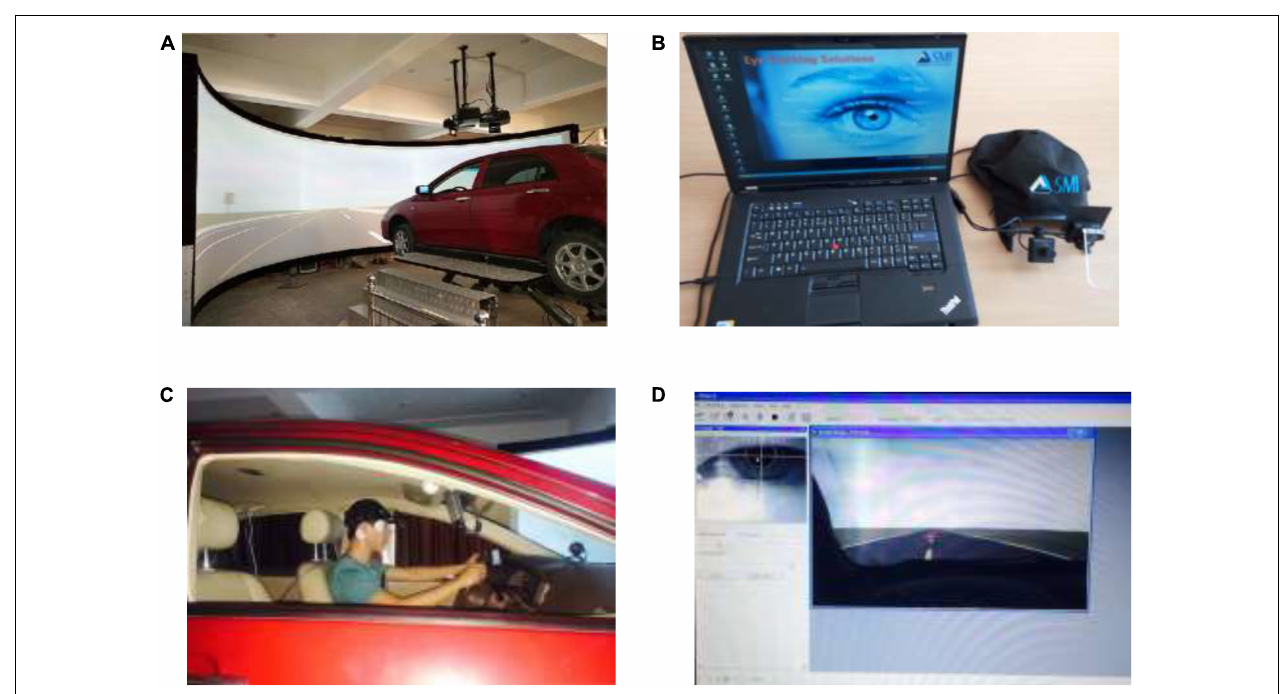
FIGURE 2 | Major apparatus. The human image in (B) is from the Eye tracker software. The human image in (C,D) is from the tested subject. (A) The driving simulation platform. (B) Eye tracker. (C) The tested subject. (D) Eye tracker recording